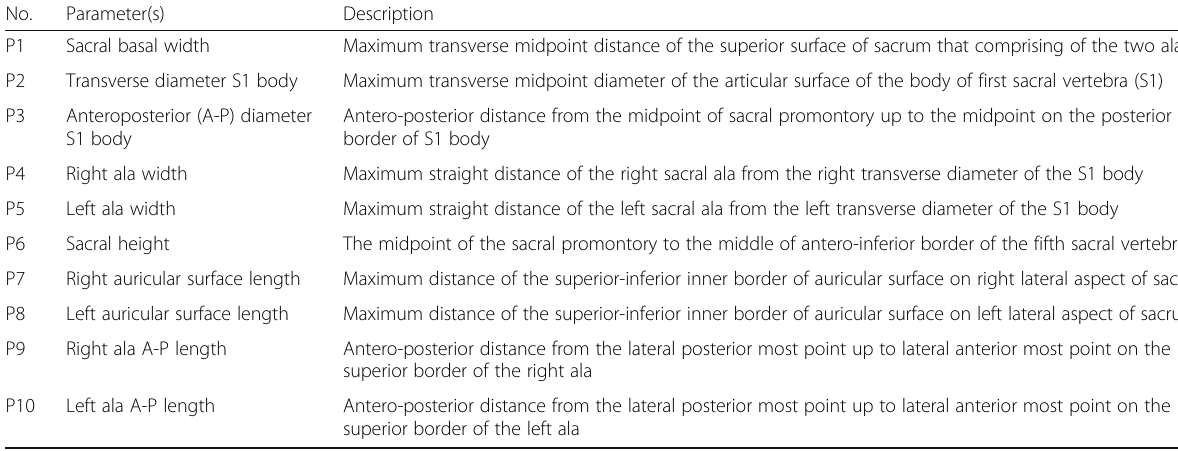
Table 2 Definition and description of sacrum parameters adopted from Kanika et al. (2011) and Shreekrishna et al. (2013) (refer to Fig. 1 for image